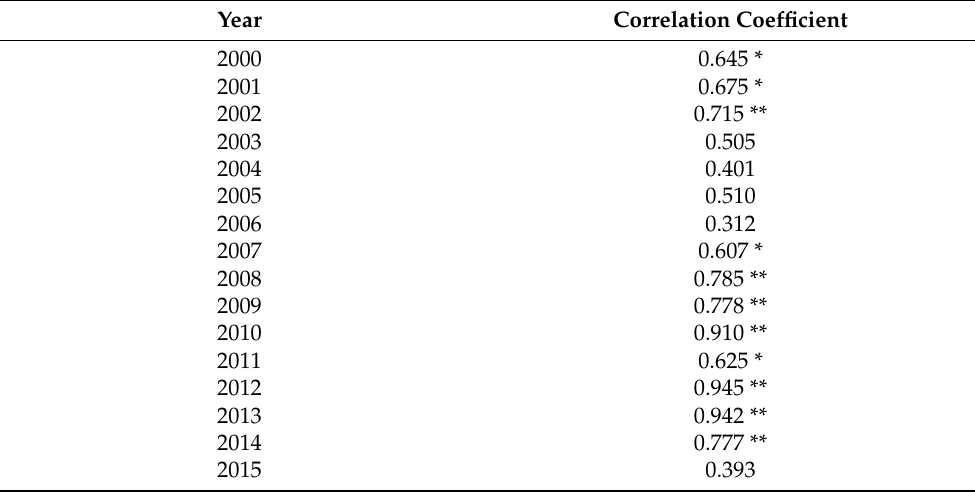
Table 1. Correlation analysis between SM and NDVI.